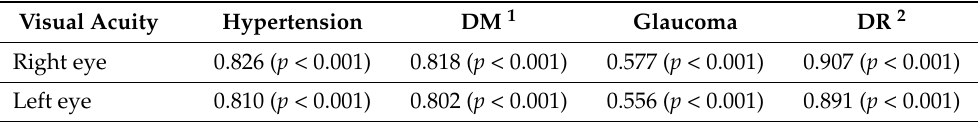
Table 4. Correlation between the frequency of diseases and mean visual acuity.